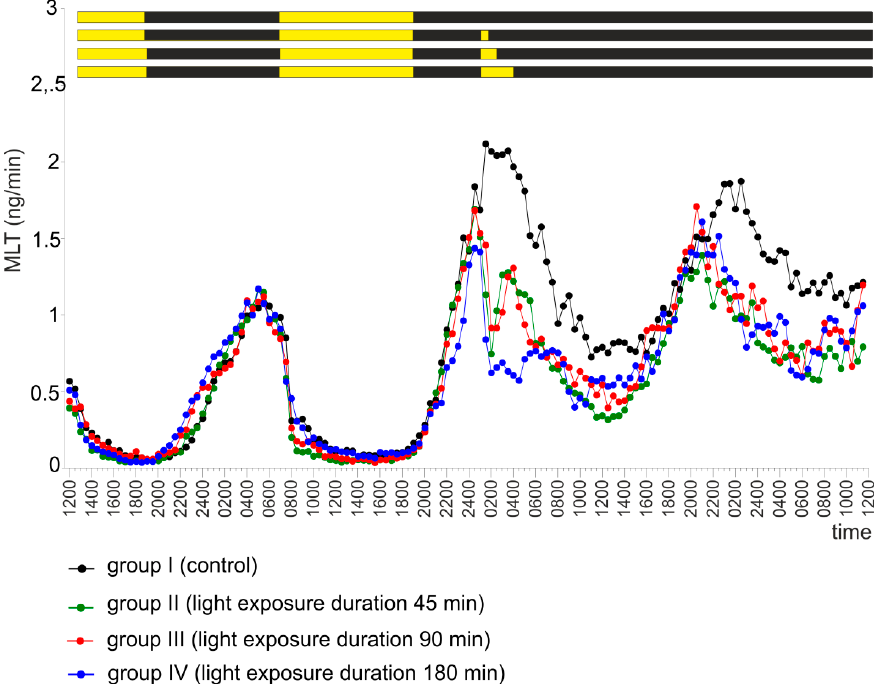
Figure 8. Experiment V. Secretion of MLT (mean) from turkey pineal organs incubated under a 12 L:12 D cycle during the first two days of the experiment and then in continuous darkness for one day. The pineal organs from groups II, III, and IV were exposed to light (fluorescent lamp, 100 lx) starting at 01.00 for 45 (group II), 90 (group III) or 180 (group IV) minutes during the second day of the experiment. Group I (control) was not subjected to any additional treatment.